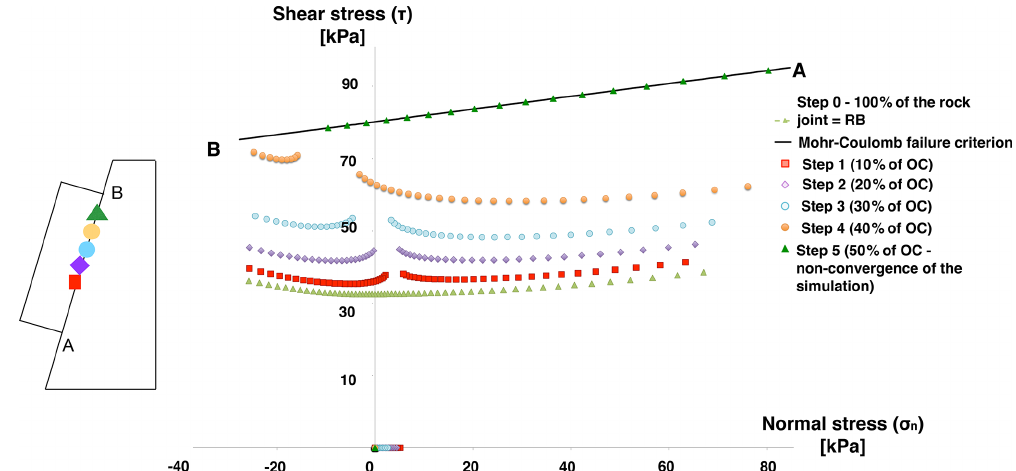
Figure 10. Distribution of the normal and tangential stresses in the plane of Mohr for model 3 considering Scenario 1. The various steps represent the introduction of 10% of open-crack (OC) contacts each time, until the non-convergence of the model.